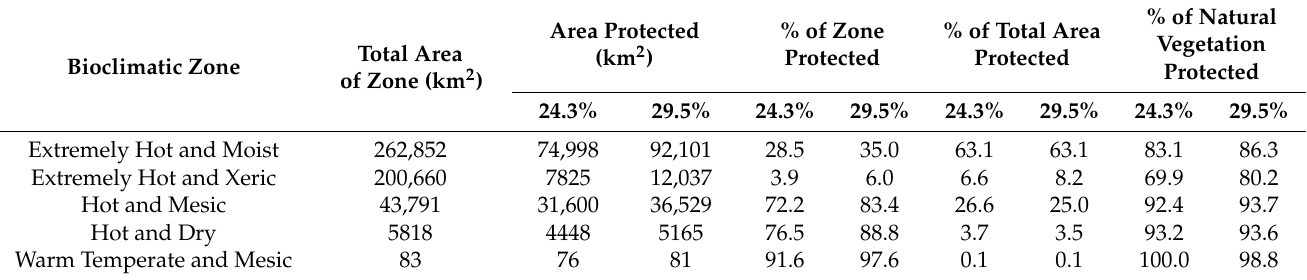
Table 1. Representation of bioclimatic zones in protected areas in Thailand currently (with 24.3% of the land area protected) and after expansion (with 29.5% protected). Data from [10].